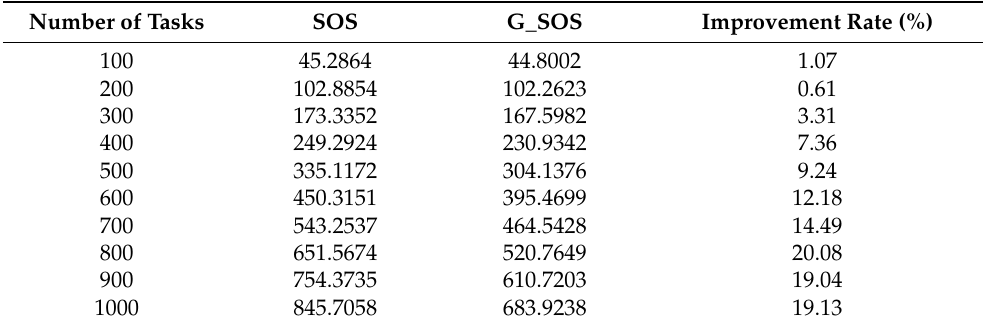
Table 4. Makepan comparison between SOS and G SOS for data instances generated from a uniformly distributed dataset.